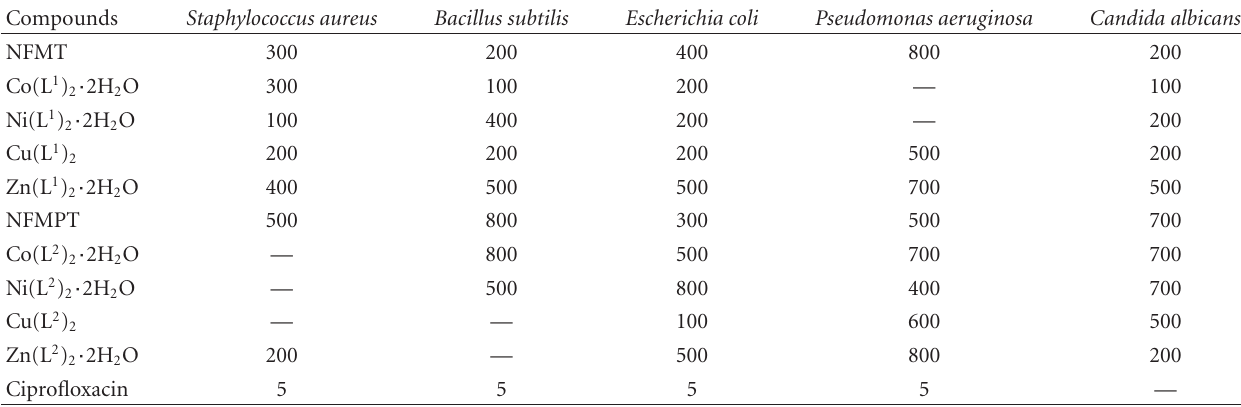
Table 6: Minimum inhibitory concentration (MIC) ( μ g/mL) of synthesized compounds.